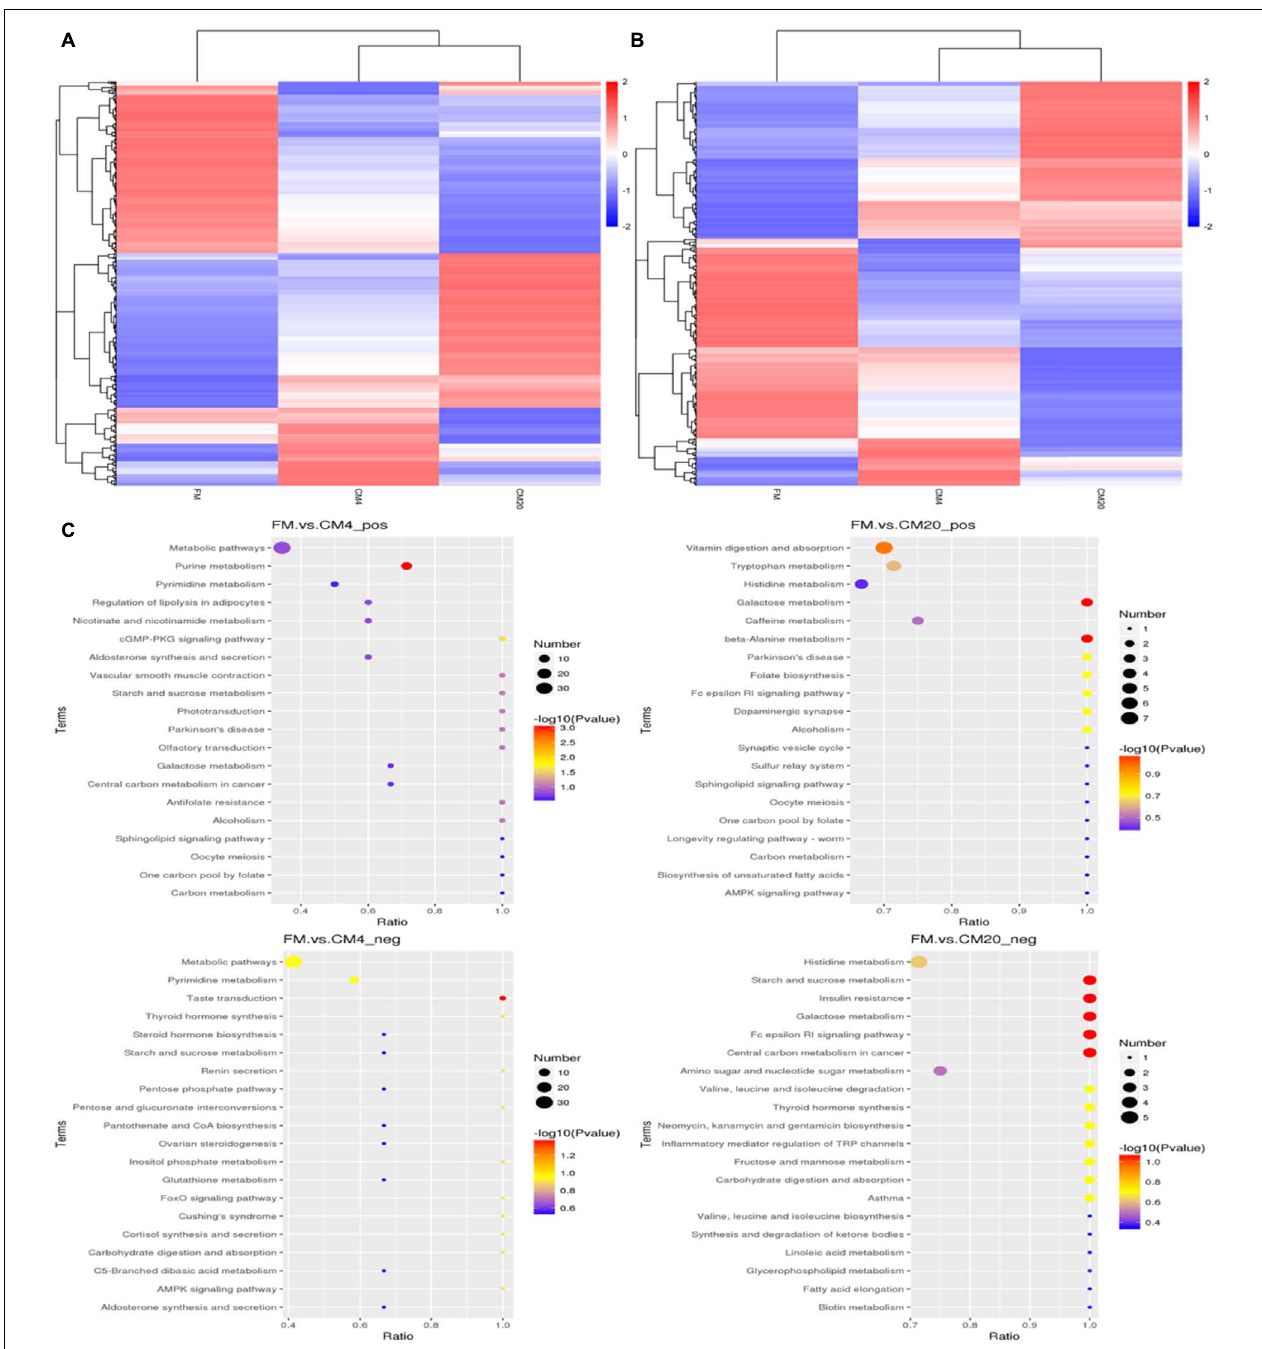
FIGURE 8 | Clustering heatmap of total differential metabolites in the positive (A) and negative (B) modes after fishmeal replacement with castor meal. Individual groups are clustered in the vertical part, whereas those of the metabolites are clustered in the horizontal part. Colour intensity indicates the intensity of the metabolite. The relationship of metabolite content clustering between groups can be seen horizontally. The shorter the cluster branch is, the higher the similarity is. (C) Scatter plot of the top 20 KEGG pathway enrichment for differential metabolites in the FM, CM4, and CM20 groups in positive (pos) and negative (neg) modes. Abbreviations are as defined in Figure 1 . n =